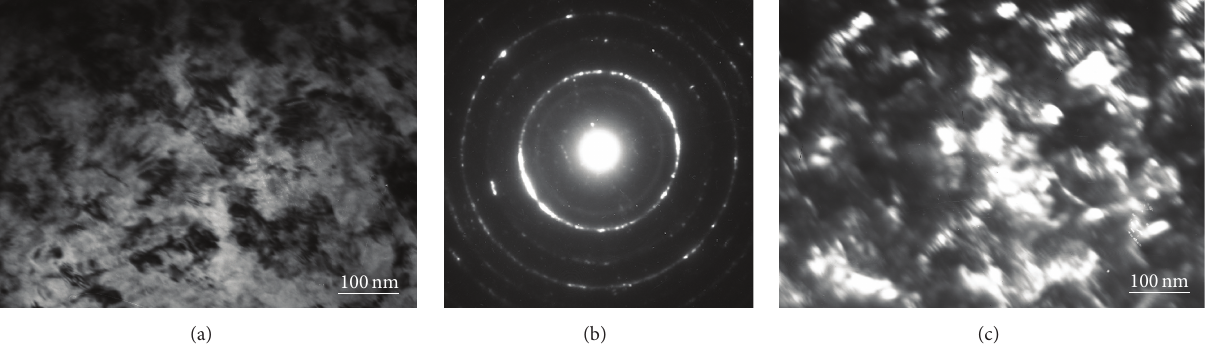
Figure 4: TEM microstructure of mature age dentin: (a) bright field, (b) electron pattern, and (c) dark field. It is in the ultrafine grain state.